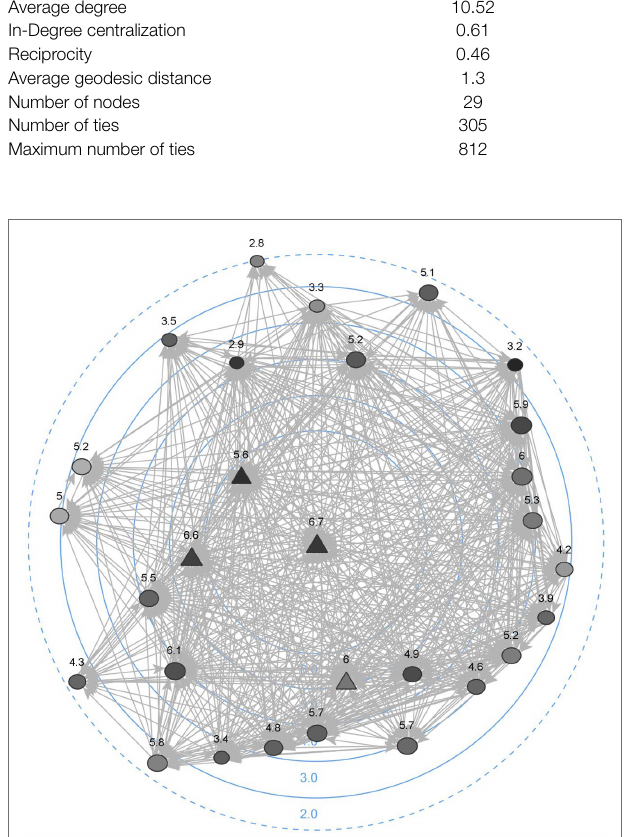
FIGURE 2 | Visualization of the shared leadership network. Circles are team members and triangles represent formal team leaders. Darker coloration indicates higher levels of political skill, while numbers indicate perceived empowering leadership (1 = low, 7 = high). Position towards the center indicates more incoming leadership